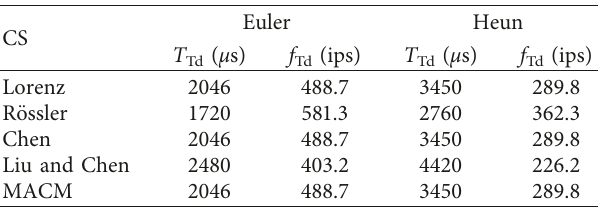
Figure 8: Implementation of Lorenz CS (15) in its DV by using the V1 of ES: (a) Phase plane x variables x ( n ) and z ( n ) . Table 7: Performance of ES in the V1 of the 3D Lorenz, R¨ossler, Chen, Liu and Chen, and MACM CSs in their DVs by using Euler (6), and Heun (7) and (8)